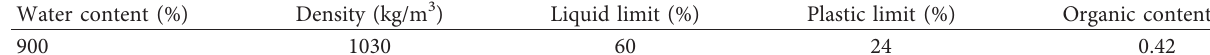
Table 1: Basic properties of the slurry.